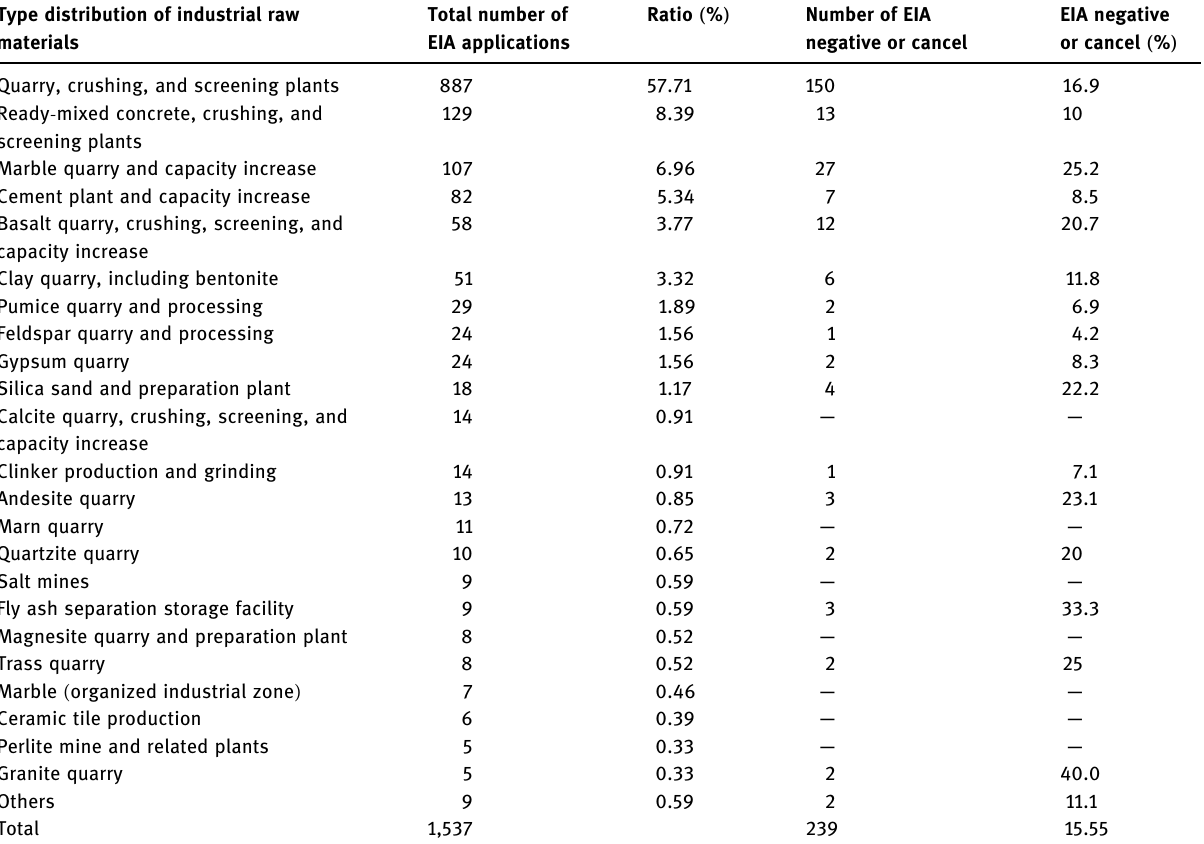
Table 2: Type distribution of industrial raw materials applications for EIA and EIA negative or cancel rates Type distribution of industrial raw